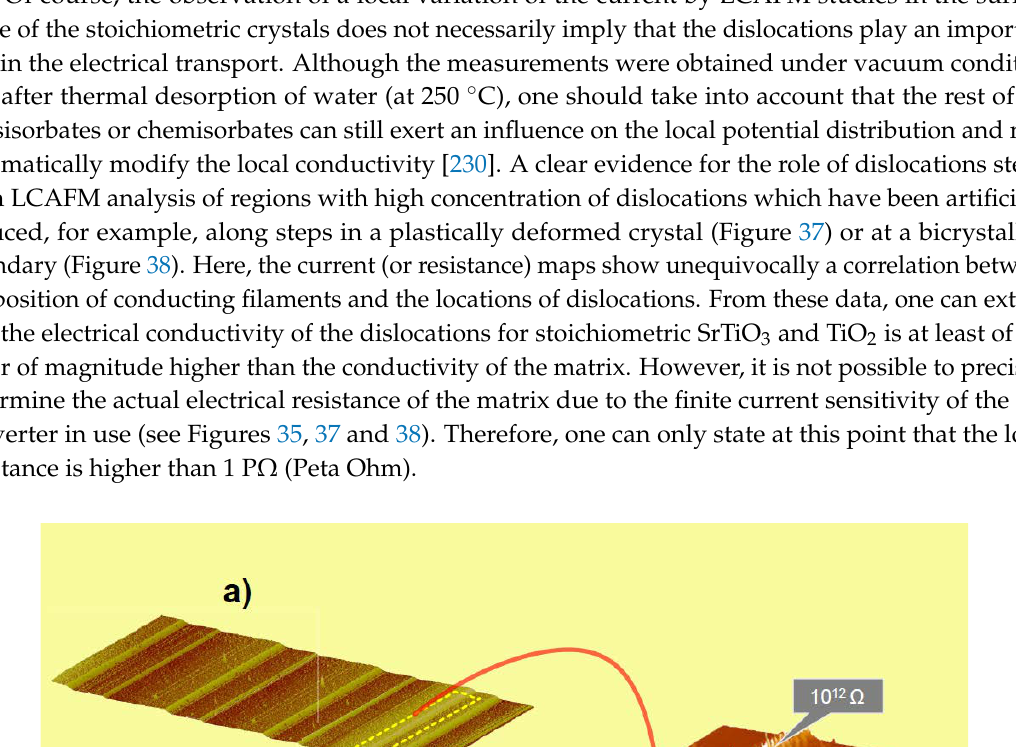
Figure 36. LCAFM image of 500 nm × 500 nm of a ‘pristine’ TiO 2 (110) surface recorded at 20 V. Adapted from [53].